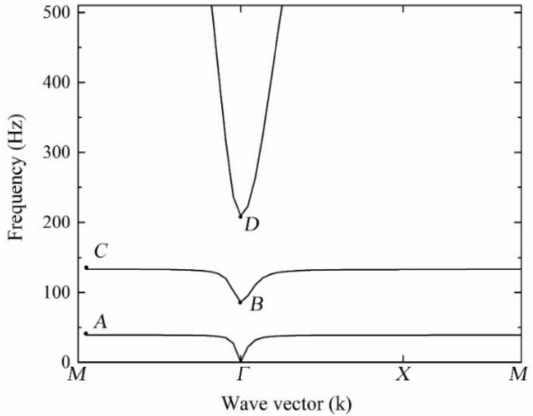
Figure 6. Band diagram of the